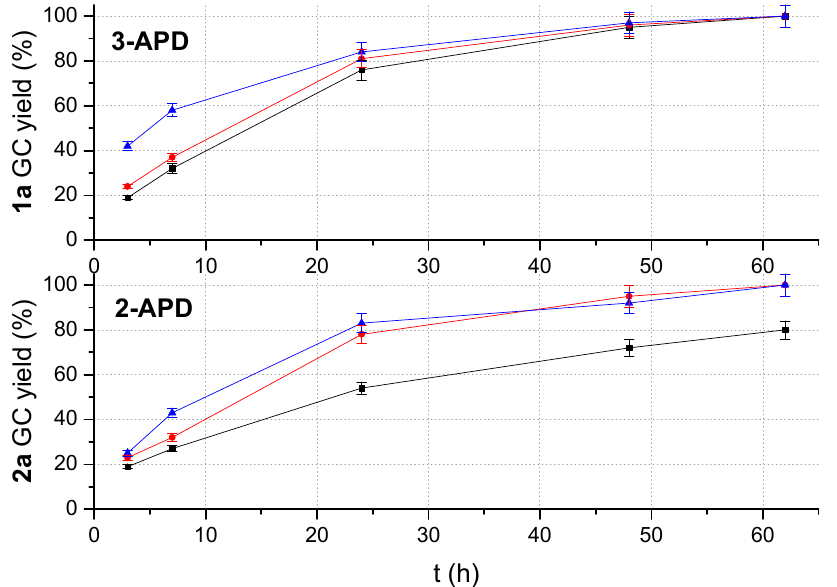
Figure 1. Batch reactions of APD isomers with iPAc. Top and bottom: GC yields of amide products 1a and 2a from 3-APD and 2-APD, respectively, at T = 80 °C (- ■ -), 90 °C (- ● -), and 100 °C (- ▲ -). Other conditions: mixture of APD (1 mmol), iPAc (1.1 equivs.), and 1,4-dioxane as a solvent (5 mL).